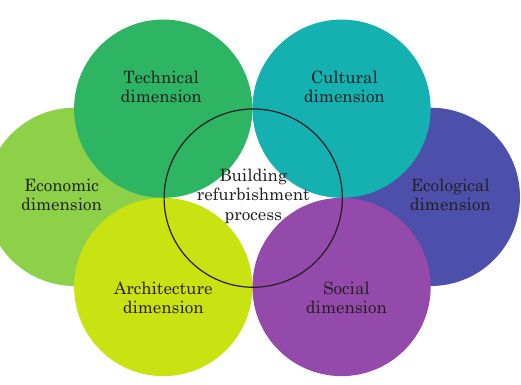
Figure 1. The model of sustainable buildings